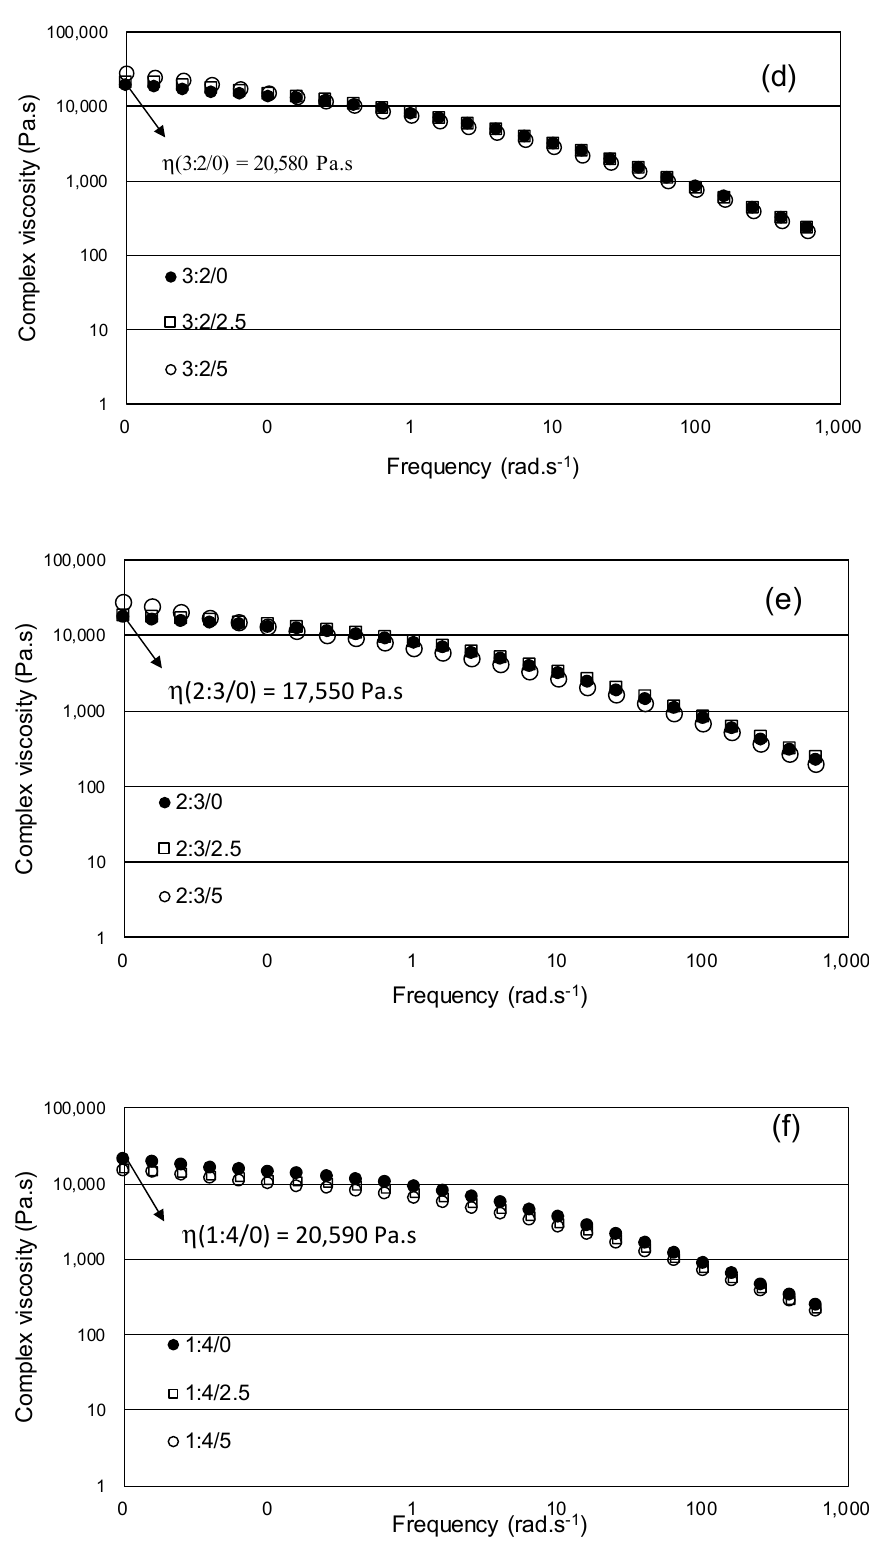
Figure 19. Complex viscosity versus frequency curves for: ( a ) PP; ( b ) HIPS and ( c – f ) 4:1, 3:2, 2:3 and 1:4 PP / HIPS blends, with 0, 2.5 and 5.0 phr CNSL